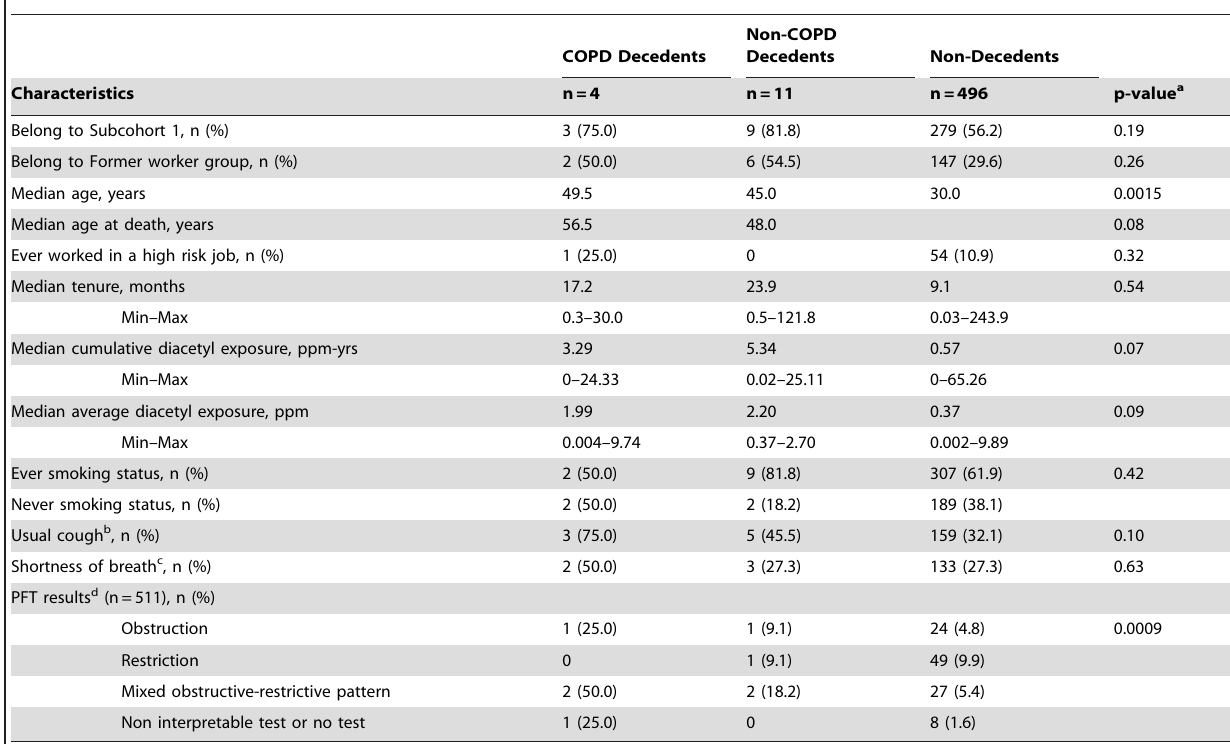
Table 3. Characteristics of COPD decedents and the remaining cohort members.